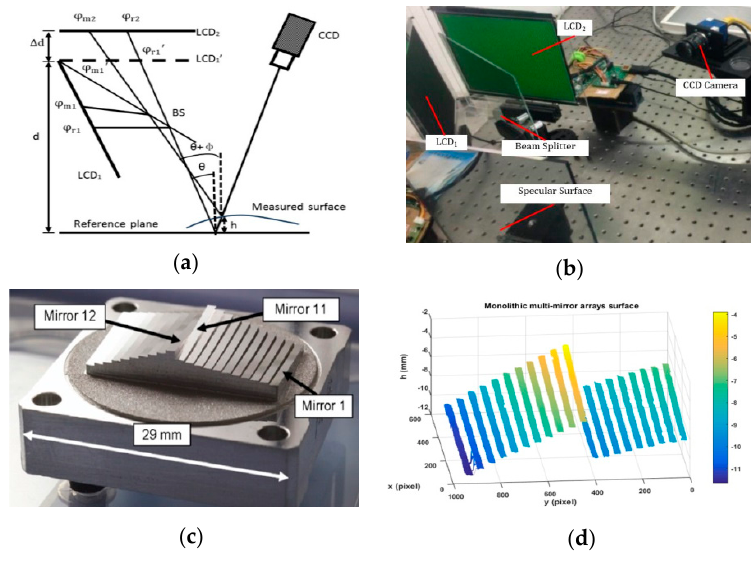
Figure 6. Measurement example of DPMD. ( a ) Principle of DPMD. ( b ) Hardware of the experimental setup. ( c ) Monolithic multi-mirror array on the MIRI spectrometer optics for the James Webb Space Telescope. ( d ) Measured depth.